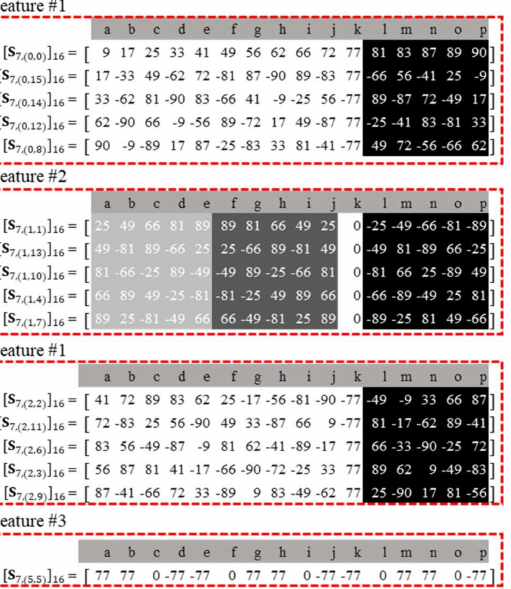
Figure 18. Application of the proposed 16 − point grouped DST − 7 transform to a fast algorithm in